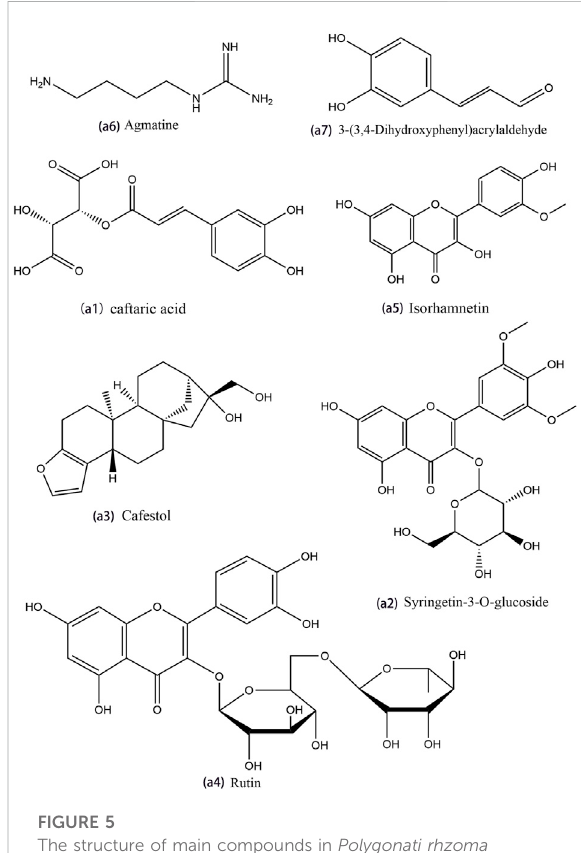
FIGURE 5 The structure of main compounds in Polygonati rhzoma